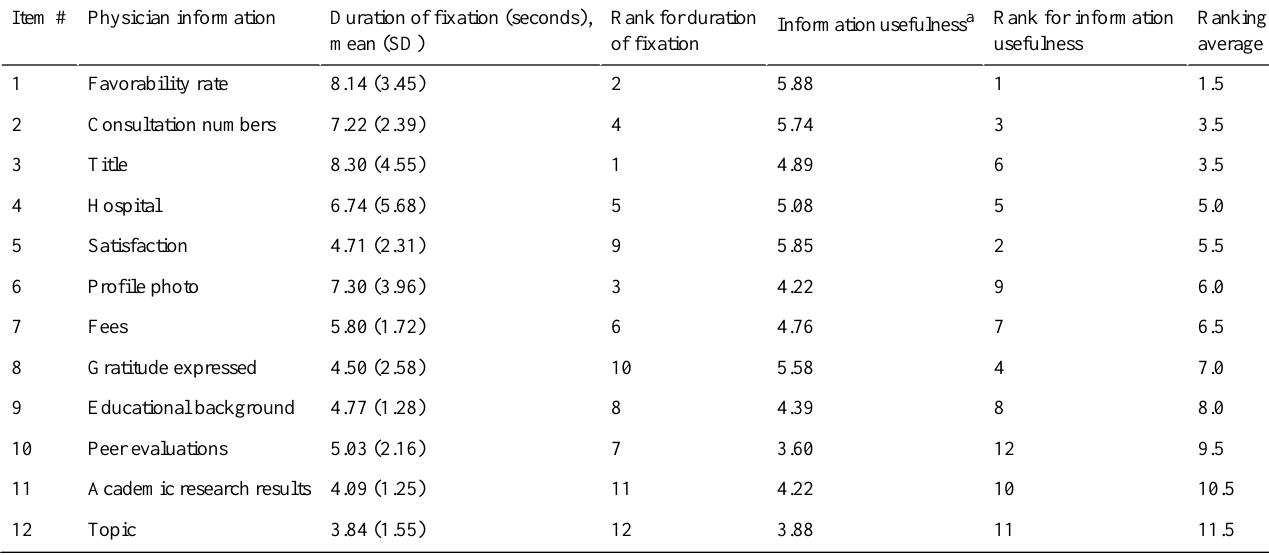
Table 3. Ranking of 12 types of physician